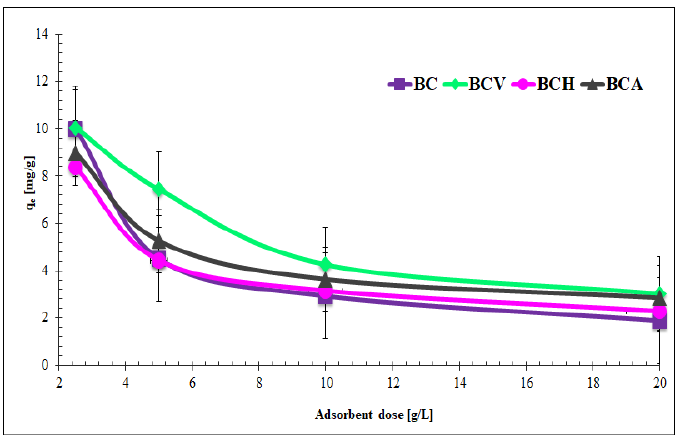
Figure 4. Effect of biochar dosage on tetracycline adsorption (C 0 = 90 mg/L; time = 24 h; T = 20 °C; pH = 5).